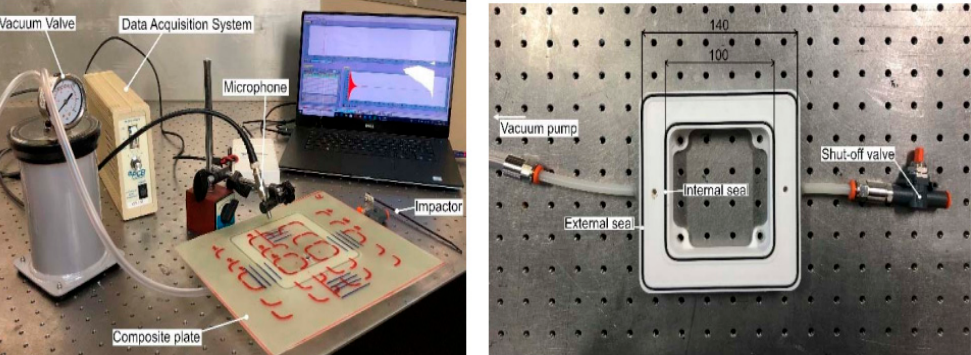
Figure 16. An experimental setup of IET method on a 3D-printed polyethyleneterephthalate (PTE) glass-fiber composite [186] (Reprinted/adapted with permission from Elsevier Ref.5457250276906 Copyright 2021).